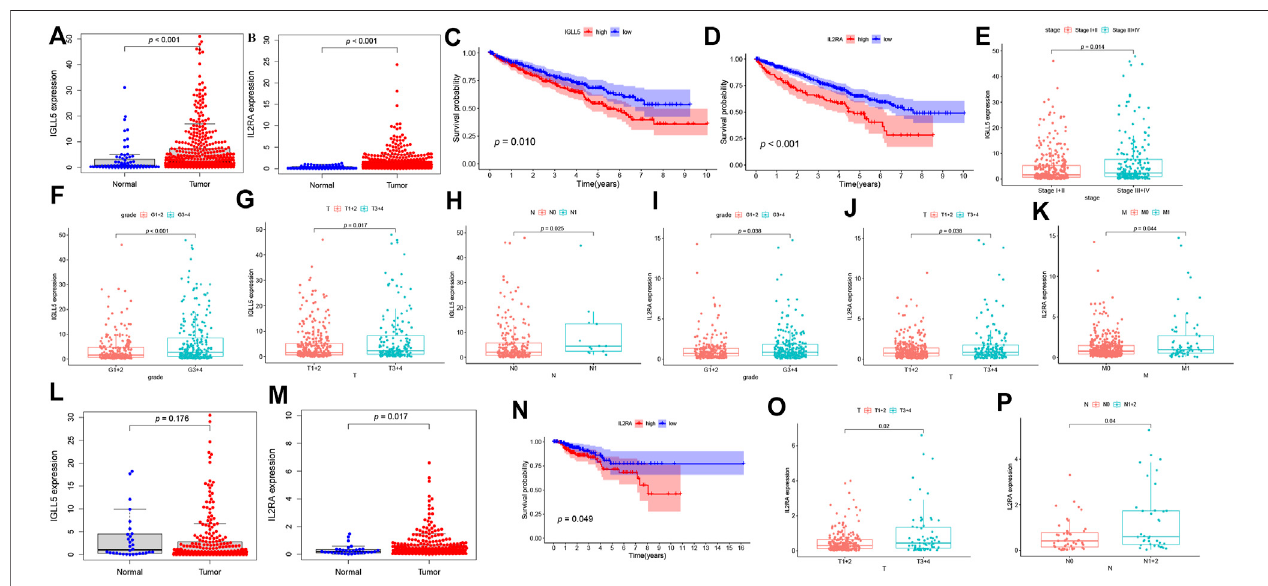
FIGURE4| SurvivalanalysisandthecliniccorrelationanalysisinccRCCandpRCC. (A-B,L-M) Differentialexpressionanalysisof IGLL5 and IL2RA inccRCC (A-B) and pRCC samples (L-M) . (C-D) Survival analysis of IGLL5 and IL2RA groups in ccRCC and pRCC samples (N) . (E-K) The correlation analyses of IGLL5 (E-H) and IL2RA (I-K, O-P) expression with clinicopathological parameters in ccRCC and pRCC samples.